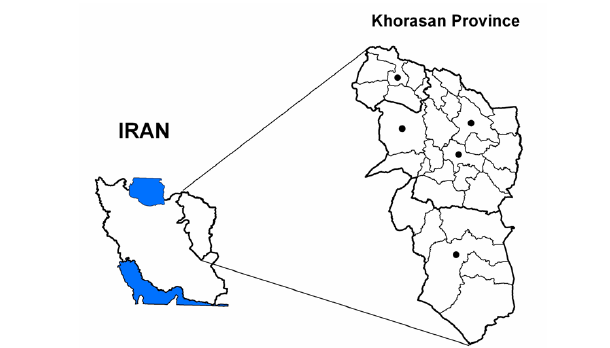
Fig.1. Location map of sampling